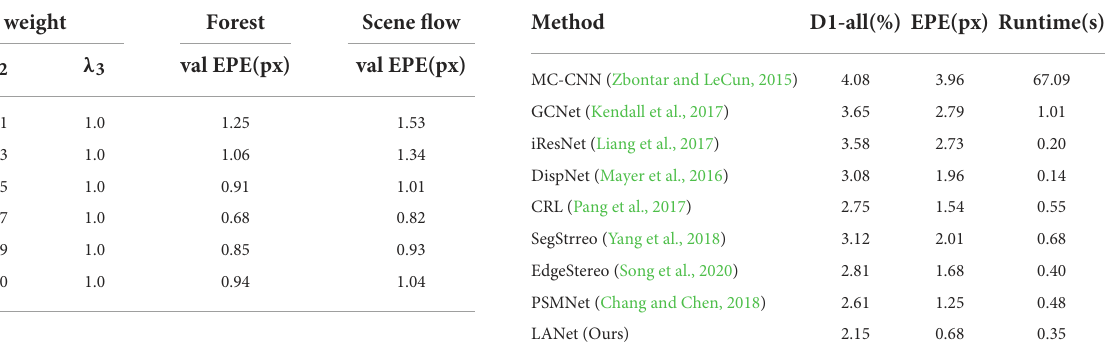
TABLE 6 Setting of weighting factors. TABLE 7 Comparison experiments on Forest.